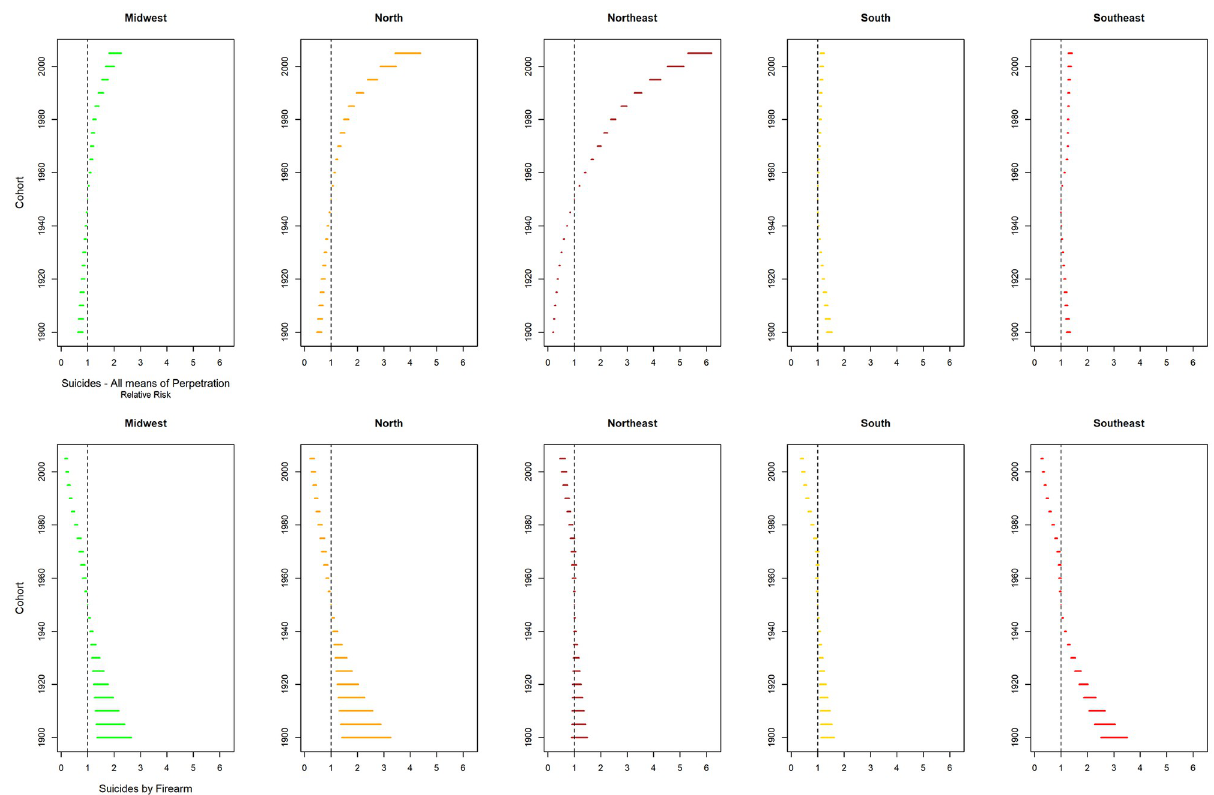
Fig 8. Risk of death (relative risk) by cohort, adjusted for age and period effect, for total suicide and suicide by firearms, from 1980 to 2019, Brazil and major regions.